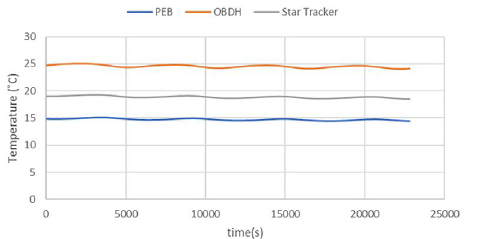
Fig. 7: Structural panels temperature change.